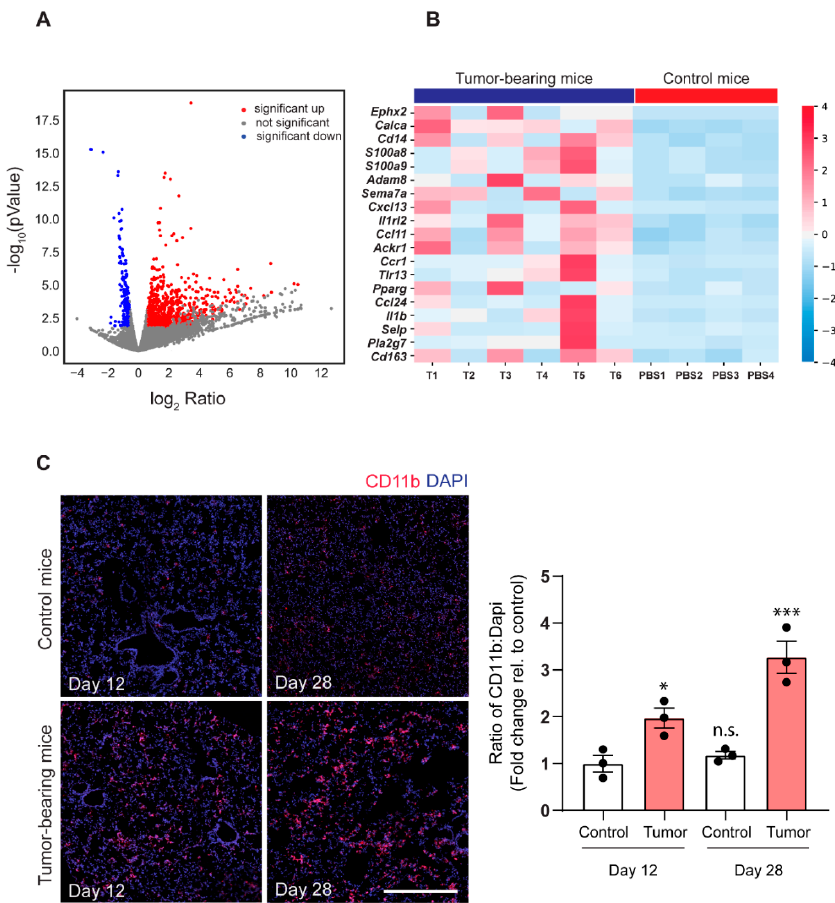
Figure 2. Transcriptomic profiling of pre-metastatic lungs demonstrates an inflammatory response and myeloid cell infiltration. ( A ) Volcano plot of differentially expressed genes in pre-metastatic lungs compared to control lungs. Dots colored in red or blue represent upregulated and downregulated genes, respectively, meeting the thresholds of fold change > 1.5, p -value < 0.01, and FDR < 0.2 respectively. ( B ) Heatmap representation of upregulated genes under the GO term “inflammatory response” (GO:0006954) in tumor-bearing mice vs. control mice. Each column represents one biological replicate ( n = 6 in the tumor group (T1–T6), n = 4 in the control group (PBS1–PBS4)). Cut-o ff values of fold change are > 1.5 and FDR < 0.2. The clustering separates the genes by color with positive or negative row-scaled Z-scores represented in red and blue, respectively. ( C ) Representative immunofluorescence images (left panel) and quantification (right panel) of CD11b + cells (red) and nuclei (blue) in lungs of control mice (day 12 and day 28) and tumor-bearing mice (day 12 and day 28), respectively. Scale bar, 500 µ m. (n.s., non-significant, *, p < 0.05, ***, p = 0.001; Bonferroni’s one-way ANOVA